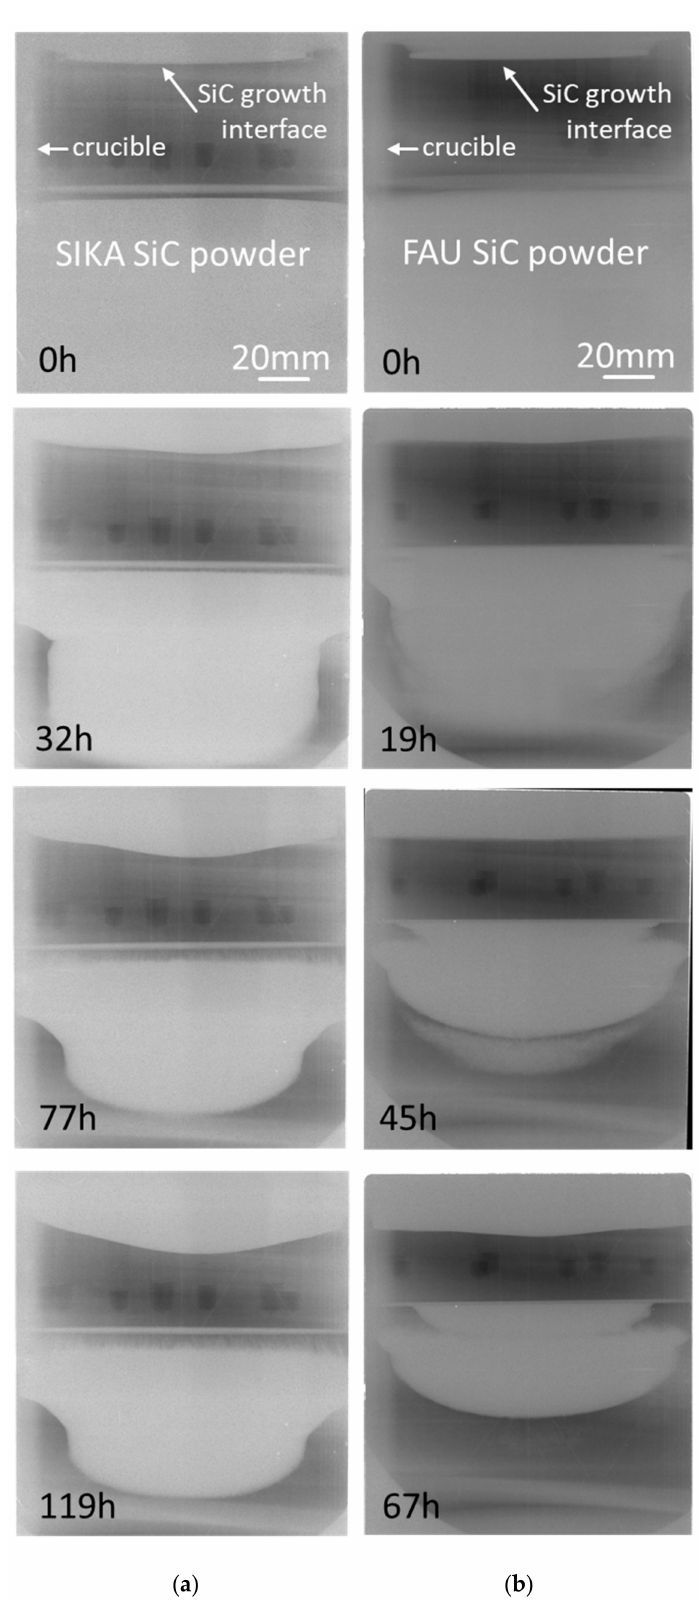
Figure 6. Series of 2D in situ X-ray visualization of the growth process of the 100 mm PVT growth process: ( a ) SiC powder from SIKA, and ( b ) reference SiC powder from